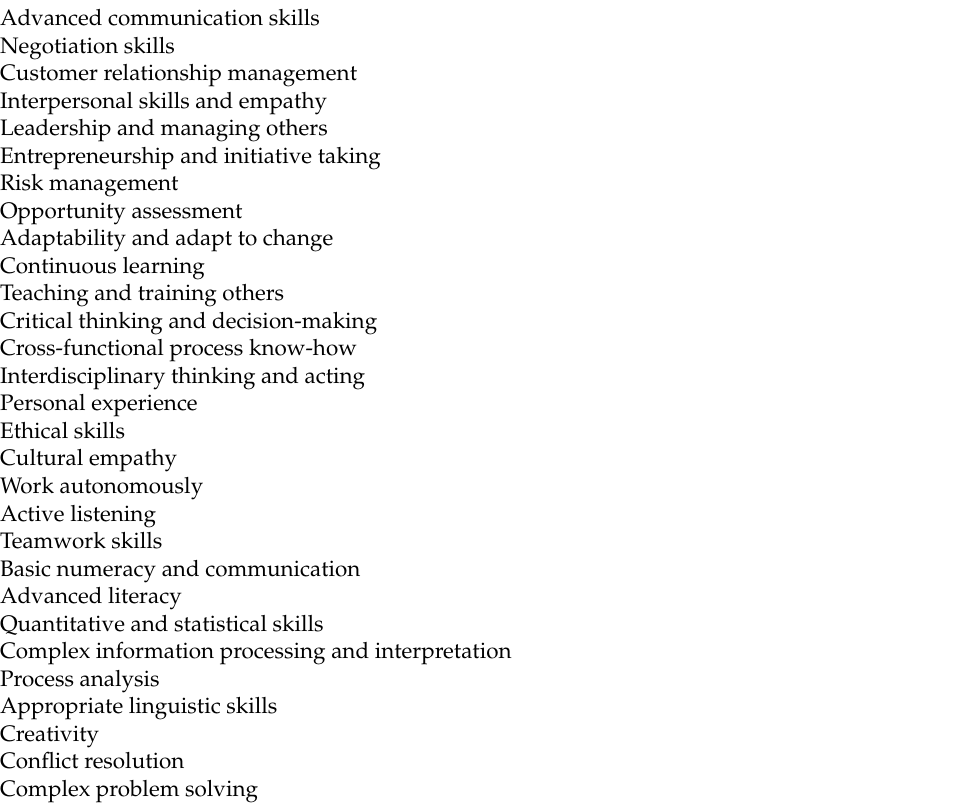
Table 3. List of selected future transversal skills for the renewable energy sector workforce. Reprinted from Akyazi, T.; Goti, A.; Oyarbide-Zubillaga, A.; Alberdi, E.; Carballedo, R.; Ibeas, R.; and Garcia- Bringas, P. 2020.